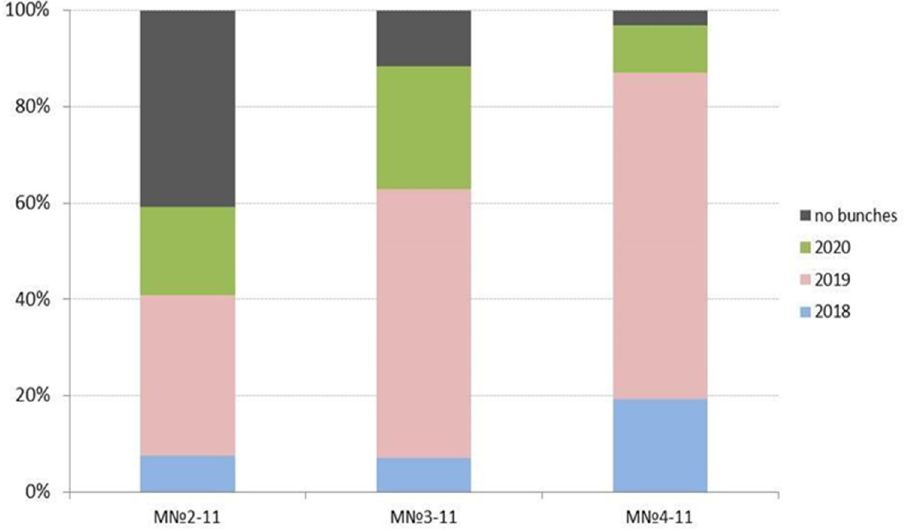
Figure 5. Difference between populations of hybrids 2-11, 3-11, and 4-11, according to the year when the first bunches were recorded. Table 2. Variation of the yield-contributing agrobiological traits between flowering plants of the hybrid populations analyzed. Field evaluation data were averaged for 2019 and 2020.